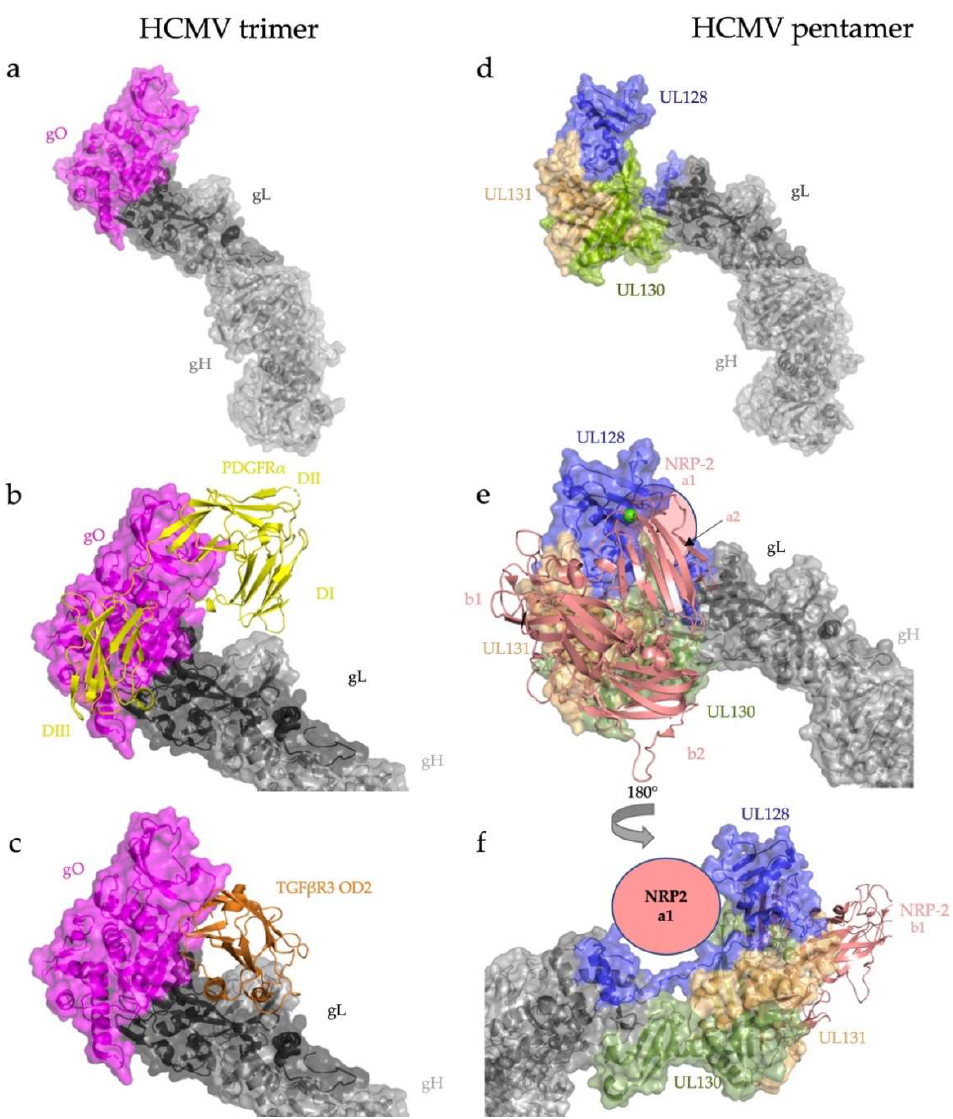
(Figure 3d) complexes are covalently linked by a single disulfide bond between the same gL cysteine and the adaptors (gO or UL128), and the amino acid sequence surrounding them is highly conserved across HCMV strains, underscoring their importance to viral replication [30,57].